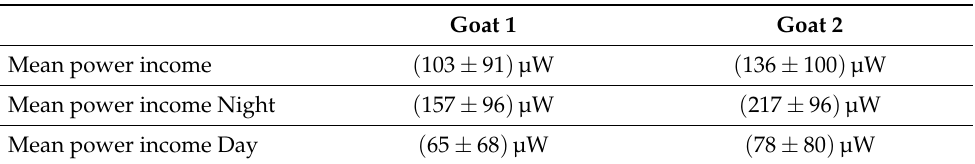
Table 2. Mean charging power of the capacitor, including losses for the up-conversion, storage, and the attached system.